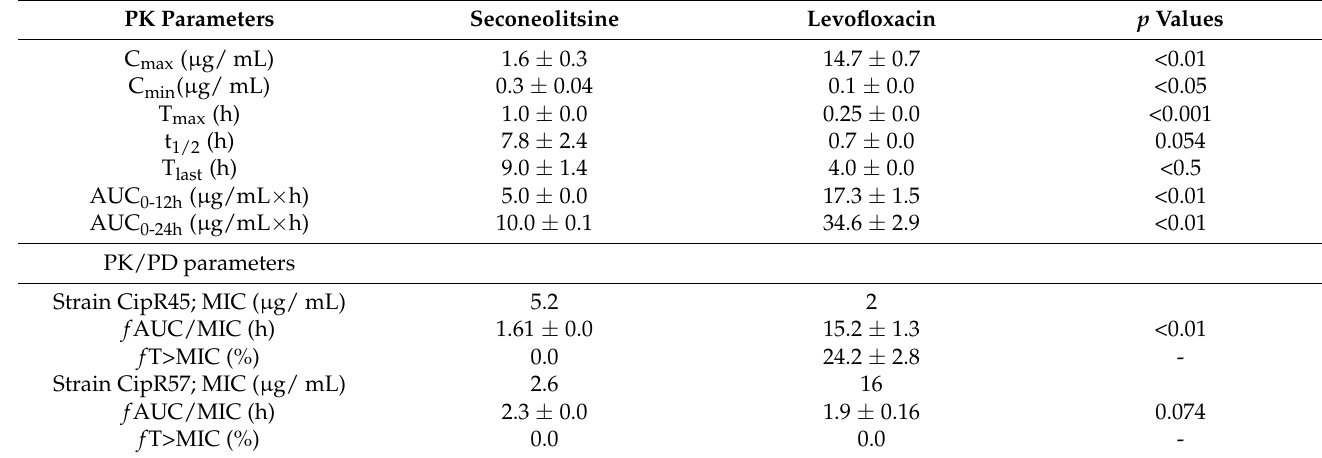
Table 2. Pharmacokinetic (mean ± standard deviation) and PK/PD parameters of seconeolitsine and levofloxacin measured in pooled sera obtained after subcutaneous inoculation of a single dose of 40 mg/kg or 50 mg/kg